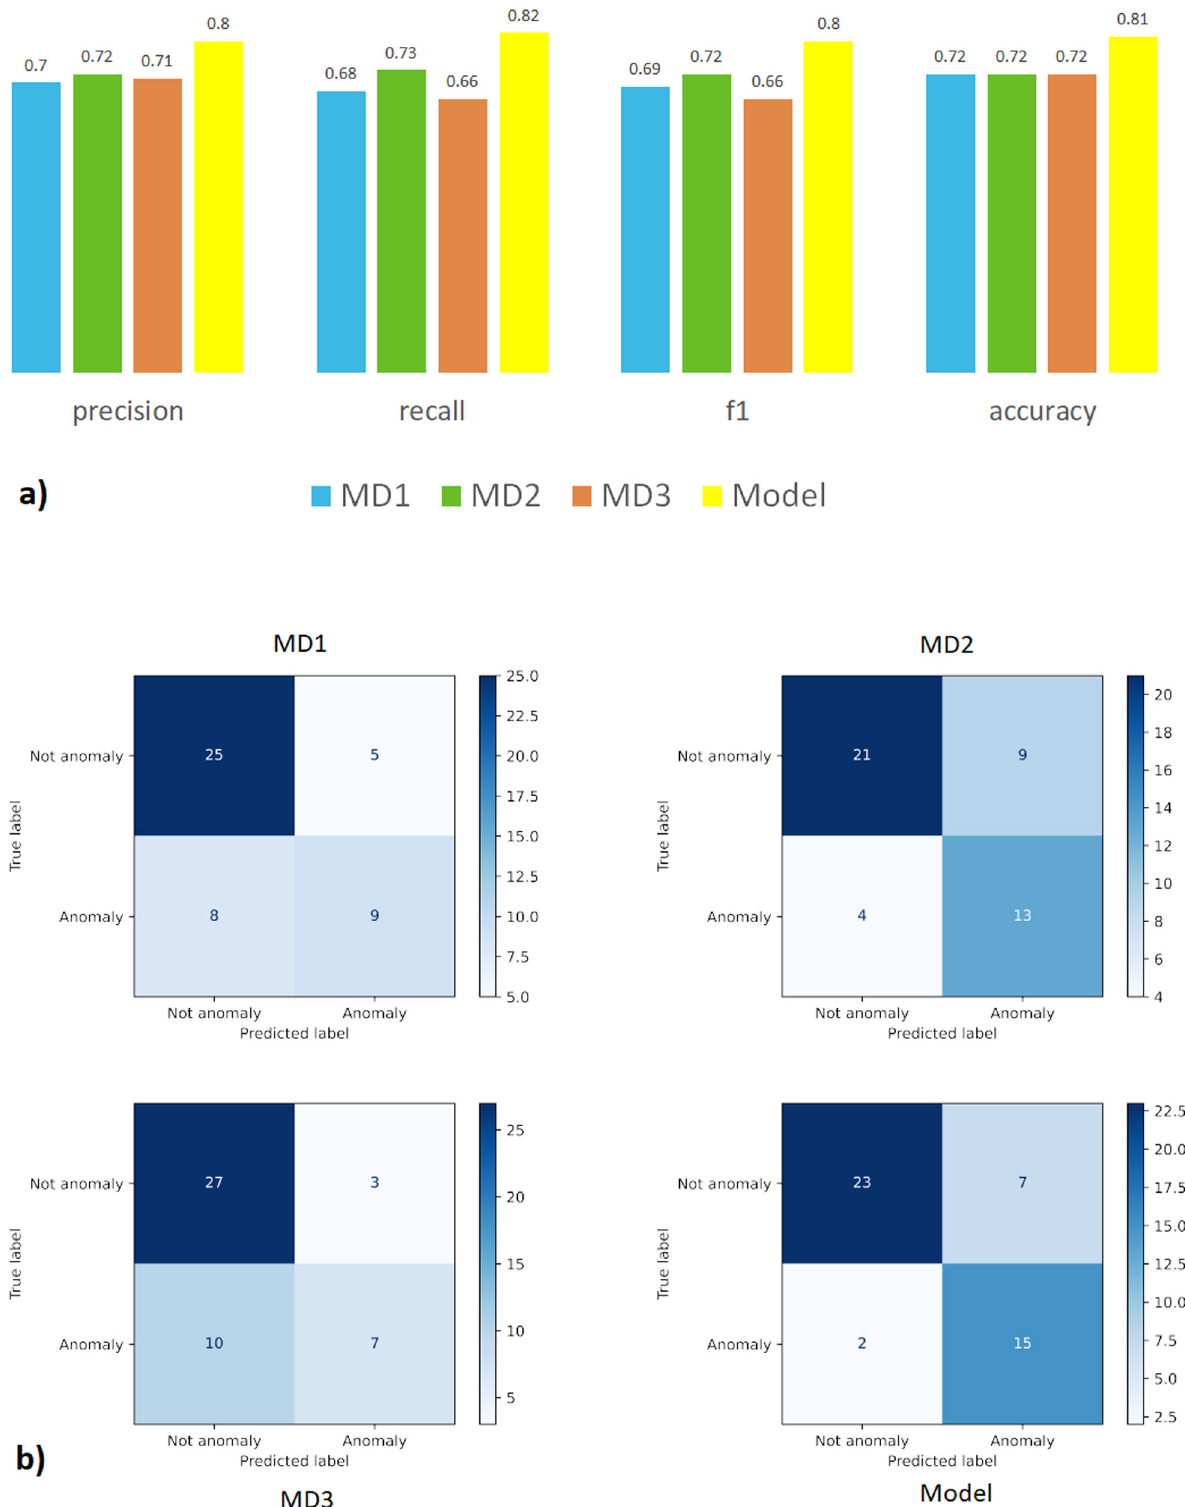
Fig. 1 Performance. a Performance (macro average of metrics) of physicians vs. model. The blue, green and orange bar indicates each physician ’ s performance and the yellow bar is the model performance. We can see that the model ’ s precision, recall, f1 and accuracy scores are all compatible with the physicians suggesting that the model can serve a role as a digital peer. b Confusion matrix. The model has the lowest false-negative rate, suggesting that the model is more conservative than all the physicians, in deciding whether a case should be considered an